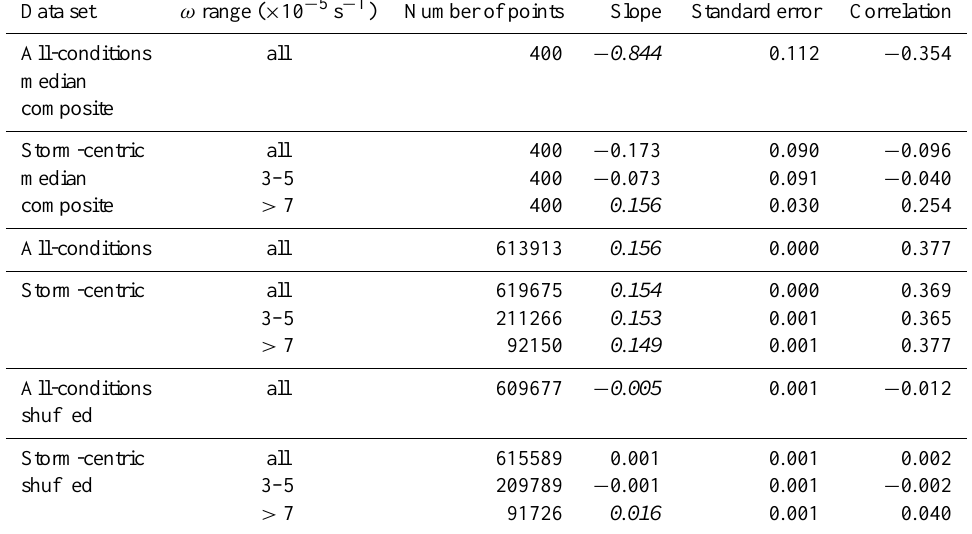
Table 2. Number of data points, slopes, standard errors on the slopes and correlations for ordinary least squares regression fits of Aqua- MODIS cloud fraction ( f c ) versus ln aerosol optical depth (ln τ ) for different all-conditions and storm-centric data sets and 850hPa relative vorticity ( ω ) ranges over the North Atlantic ocean. Slopes shown in italics are statistically significant for a t test two-tailed p value threshold of